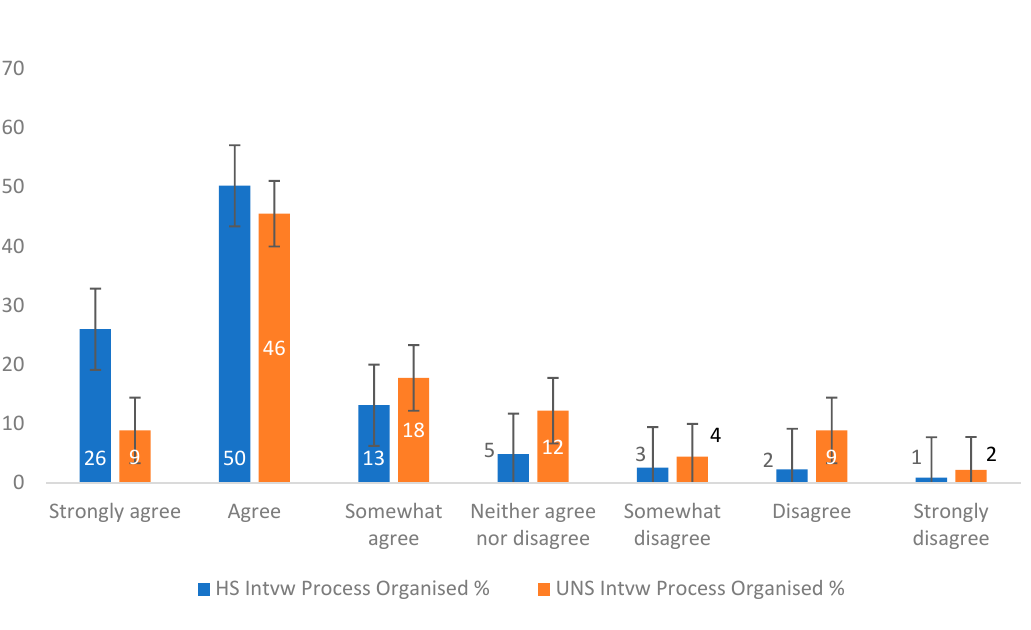
Figure 13. Process was well organised.